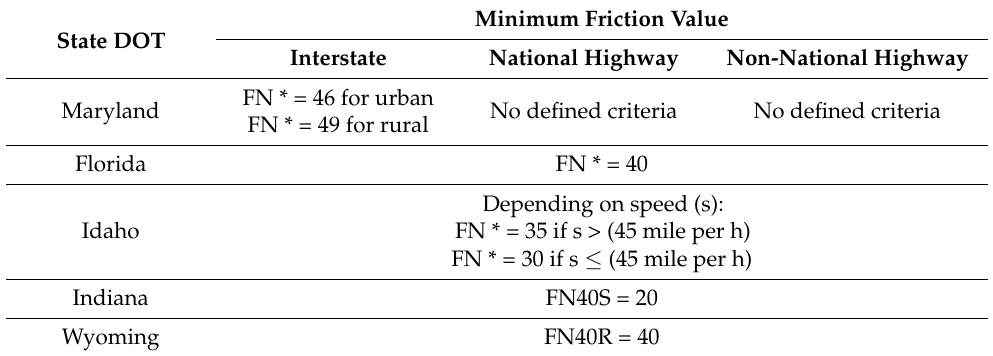
Table 5. The minimum intervention friction levels considered by the surveyed state DOTs. State